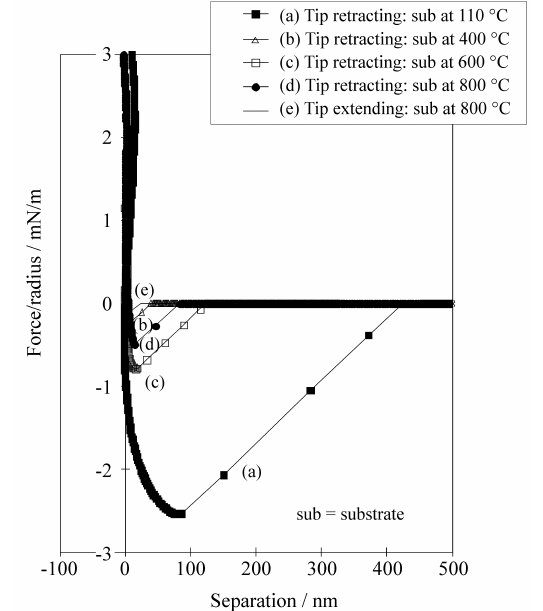
Figure 8. AFM force-distance curves for a sulfonated polysulfone tip and silica surfaces treated at different